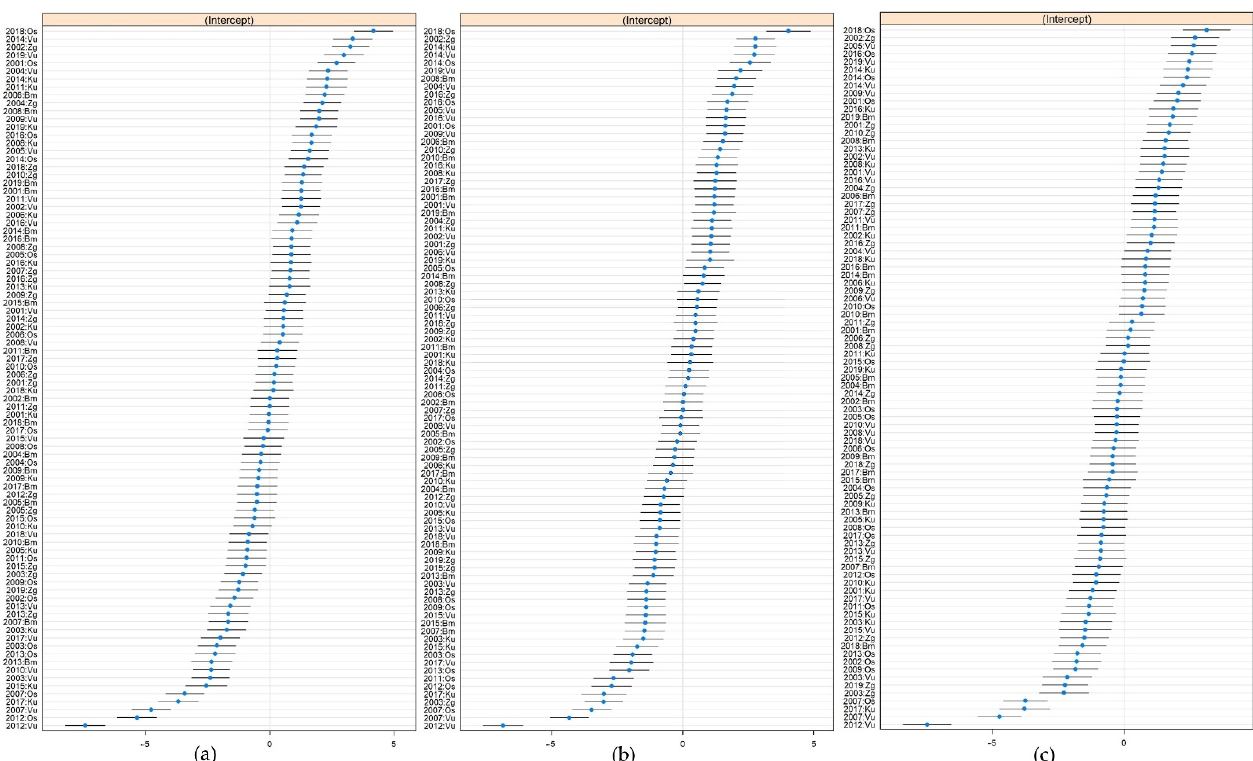
Figure 1. Dot plots of relative best linear unbiased predictions of random LY effects (Year:Location) (LY_BLUPs) in VCU trials in maize genotypes belonging to three maturity groups ( a ) FAO 300; ( b ) FAO 400; and ( c ) FAO 500.